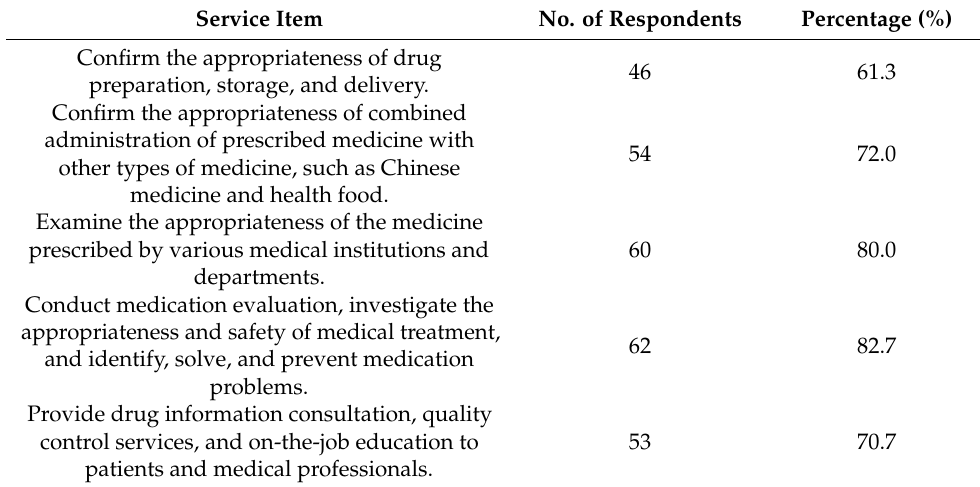
Table 7. Institutional medical service needs ( n =